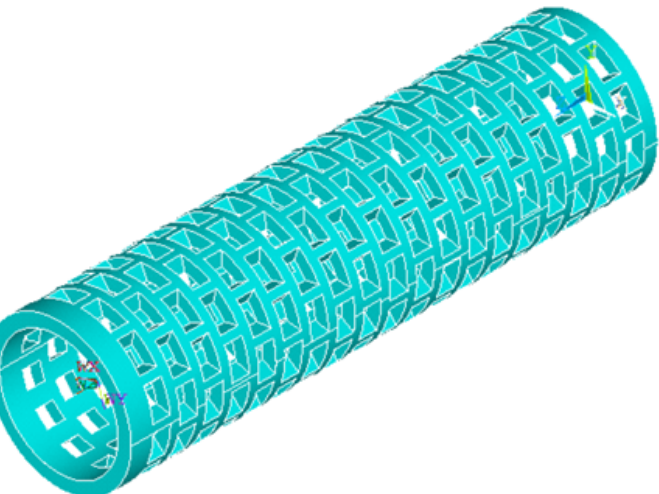
Figure 14. Optimal geometrical characteristics of the implant selected by the immune algorithm using the objective function.